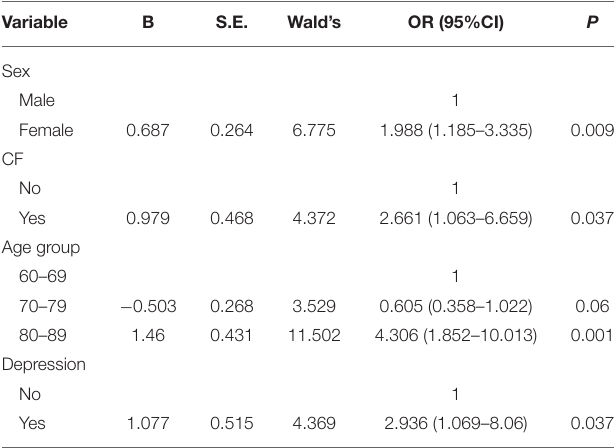
TABLE 2 | Backward selection logistic regression (LR) analysis of falls in elderly patients with hypertension.